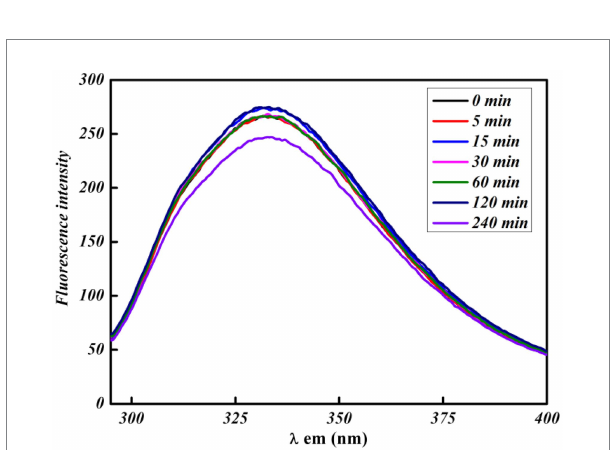
FIGURE 3 UV exposure effect at various times on bare C. albicans cells intrinsic protein